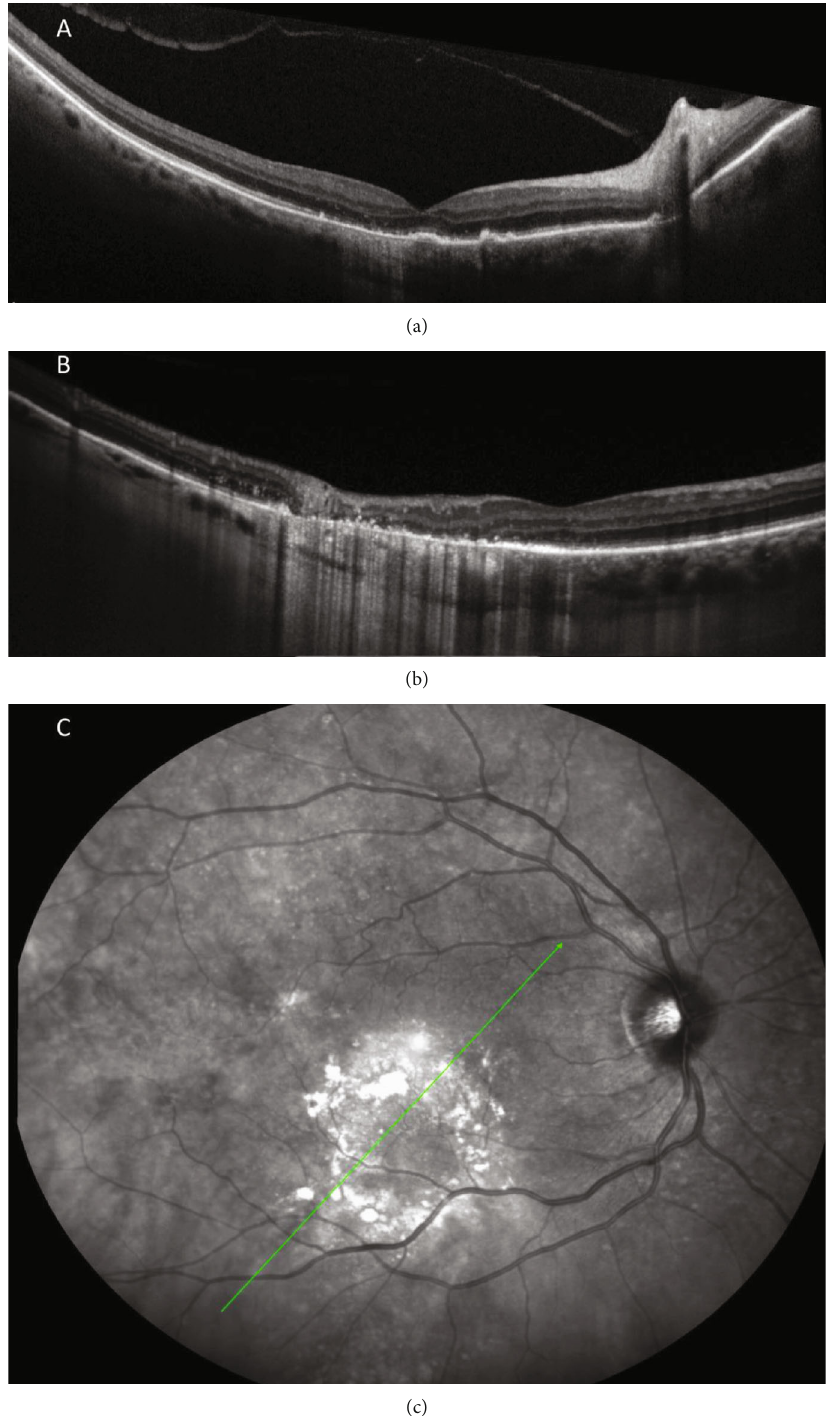
Figure 3: One month after photodynamic therapy. (a) Repeated OCT over the central macula (as seen in Figure 2(a)) showing complete resolution of the serous macular detachment. Some incomplete RPE and outer retinal atrophy (iRORA) are seen temporally along with irregularity and thickening of the RPE in the foveal region. (b, c) Coupled IR and OCT showing complete resolution of the choroidal mass under the inferior vascular arcade, with a broad complete RPE and retinal atrophy (cRORA) and subsidence of the inner retinal layers. No choroidal layer could be seen on this site. Green line (c) represents the axial orientation of the OCT scan in